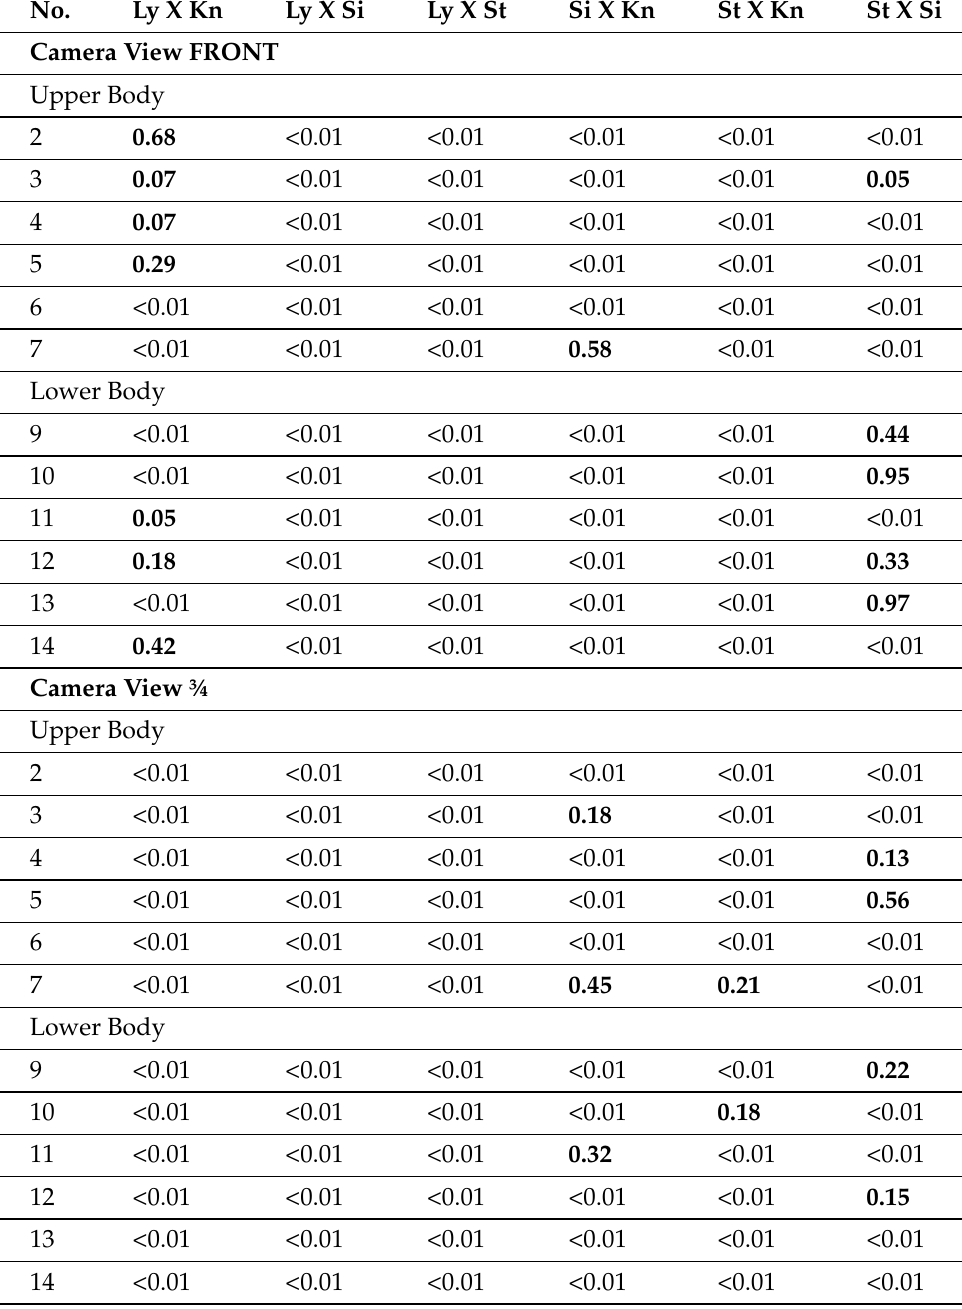
Table A1. Camera view, p -values of comparison of starting positions. Ly—Lying; Kn—on the knees; St—standing; Si—sitting. The bold values show non-significant